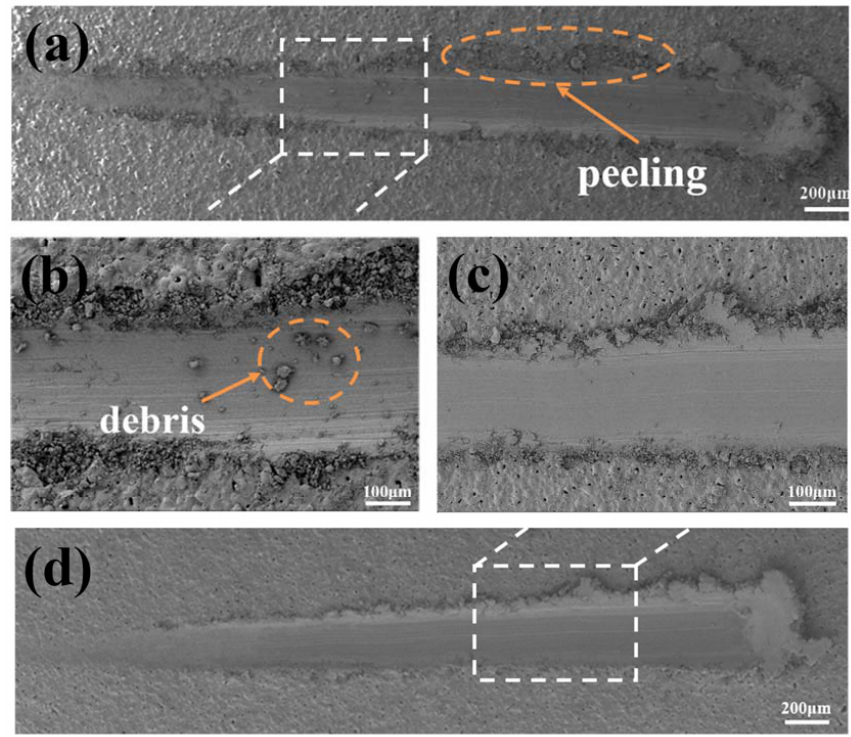
Figure 6. Scratch morphology of MAO samples: ( a , b ) CG ‐ MAO and ( c , d ) FG ‐ MAO.